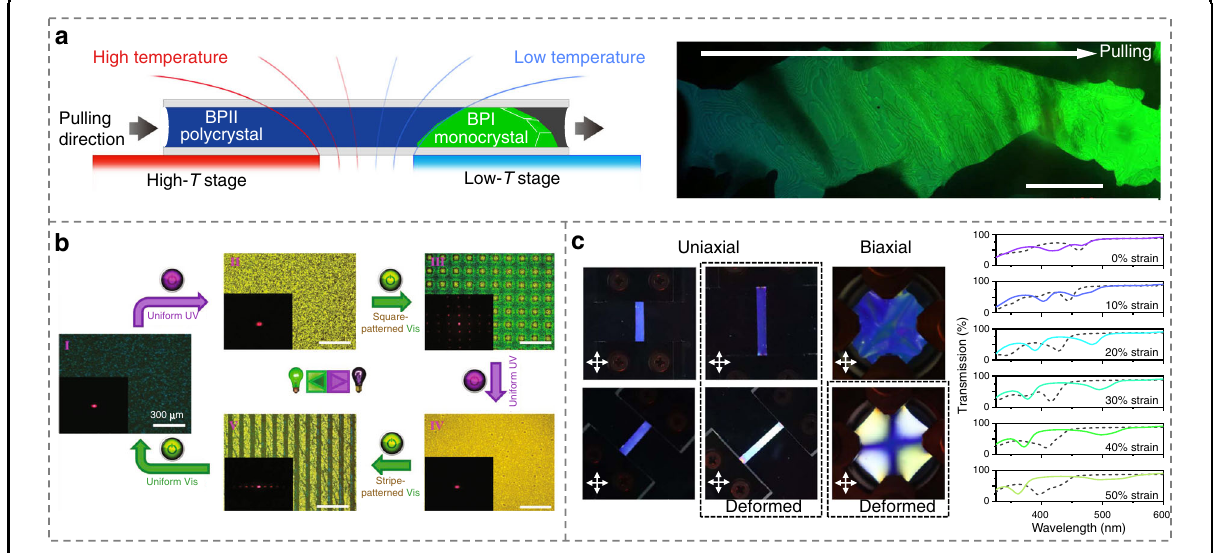
Fig. 8 Creations and modulations of photonic structures in BPLCs. a Large single photonic crystal by a gradient-temperature scanning technique 144 . Adapted from ref. 144 , with permission from Springer Nature: Nature communications. b Light-driven recon fi guration of biphasic micropatterns 146 . Reproduced from ref. 146 , with permission from Wiley-VCH. c Mechanically deformed photonic structures in BPLCs 147 . Reproduced from ref. 147 , with permission from Springer Nature: Nature